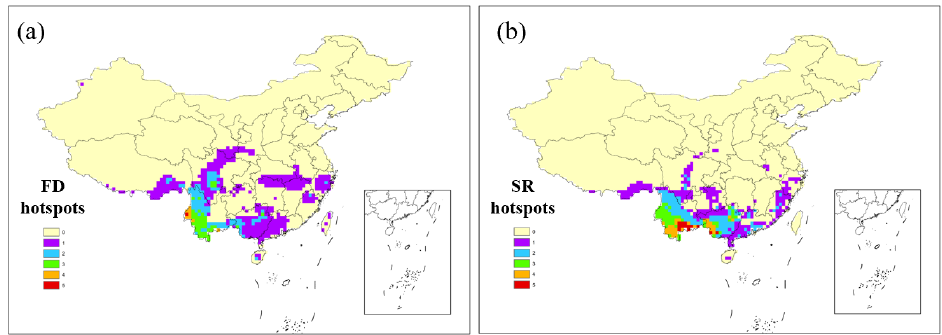
Figure 2. Overlapping of diversity hotspots among taxa. ( a ): Functional diversity hotspots; ( b ): Species richness hotspots. The map content approval number is GS(2019)1822.